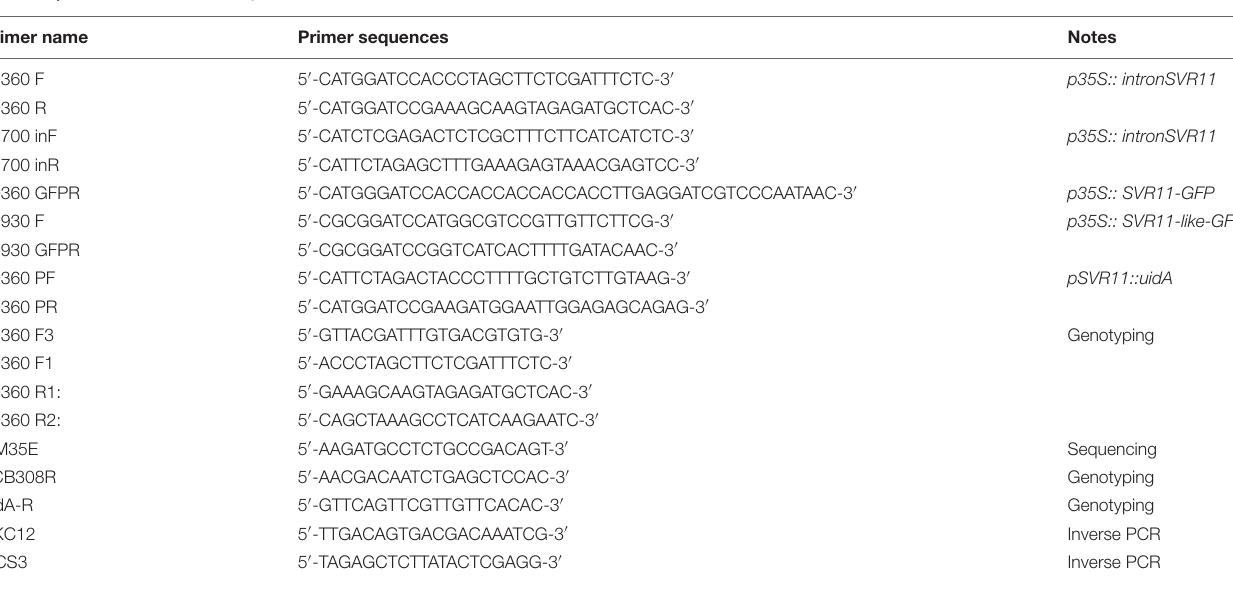
TABLE 1 | Primers used in this